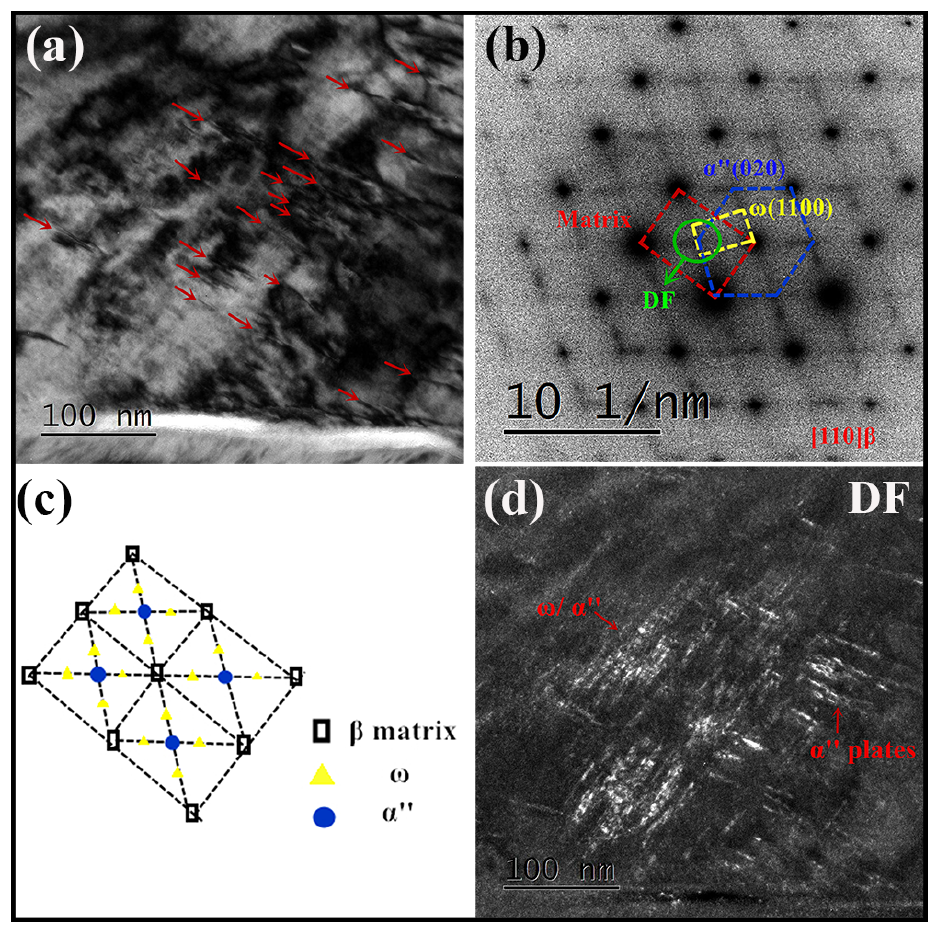
Figure 3. ( a ) BF-TEM image of α ” phases (indicated by the red arrows) observed in the 80% cross-rolled sample; ( b ) SAED pattern along [ 110 ] β zone axis corresponding to Figure 3a; ( c ) Schematic illustrating the position of di ff raction spots in Figure 3b (black: β spots; yellow: ω spots, blue: α ” spots); ( d ) DF-TEM micrograph taken from the di ff raction spots indicated by the green circle in Figure 3b.